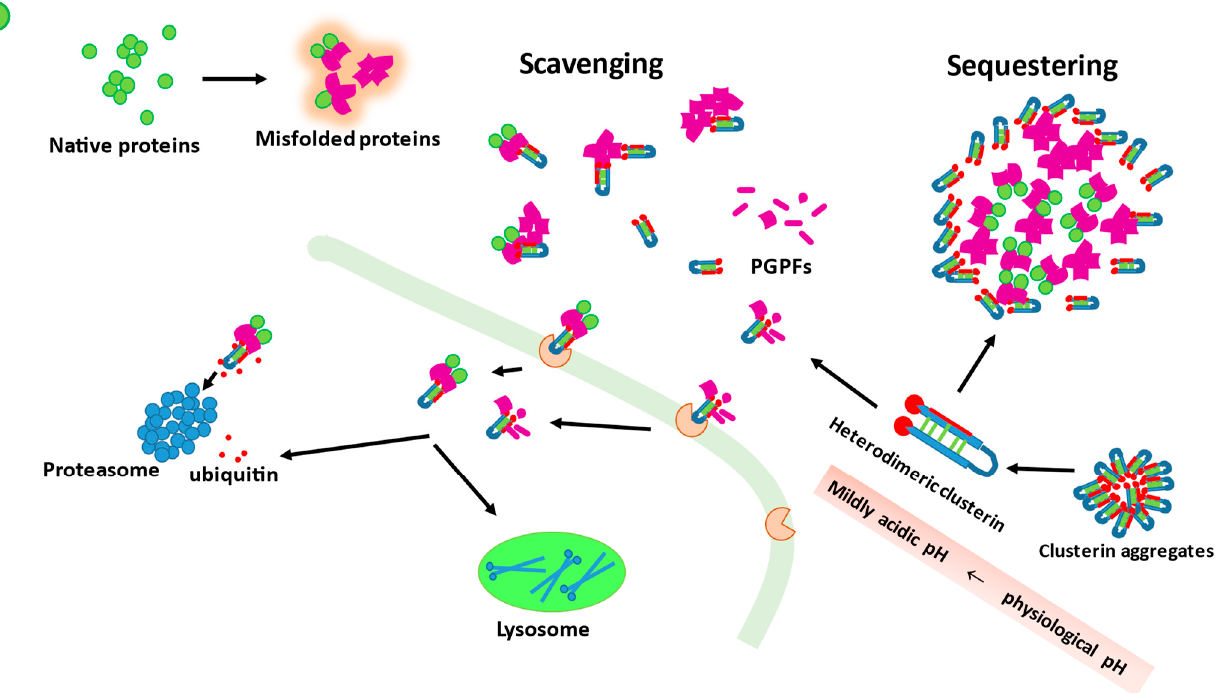
Figure 1. Clusterin molecules can form aggregates that serve as their reservoirs. Clusterin can act as a scavenging or sequestering agent. As a scavenger agent, it can bind misfolded, toxic proteins as well as plasmin-generated protein fragments (PGPFs). The complexes between misfolded protein (or PGPFs) and clusterin are recognized by membrane receptors and trafficked inside the cell where they are degraded either by proteasomes or lysosomes. In an excess of client protein molecules, clusterin can work as a sequestering agent surrounding misfolded toxic molecules and thus preventing their toxicity. Dissociation of clusterin aggregates into heterodimeric fully active forms is enhanced when pH changes from physiological values to mildly acidic.